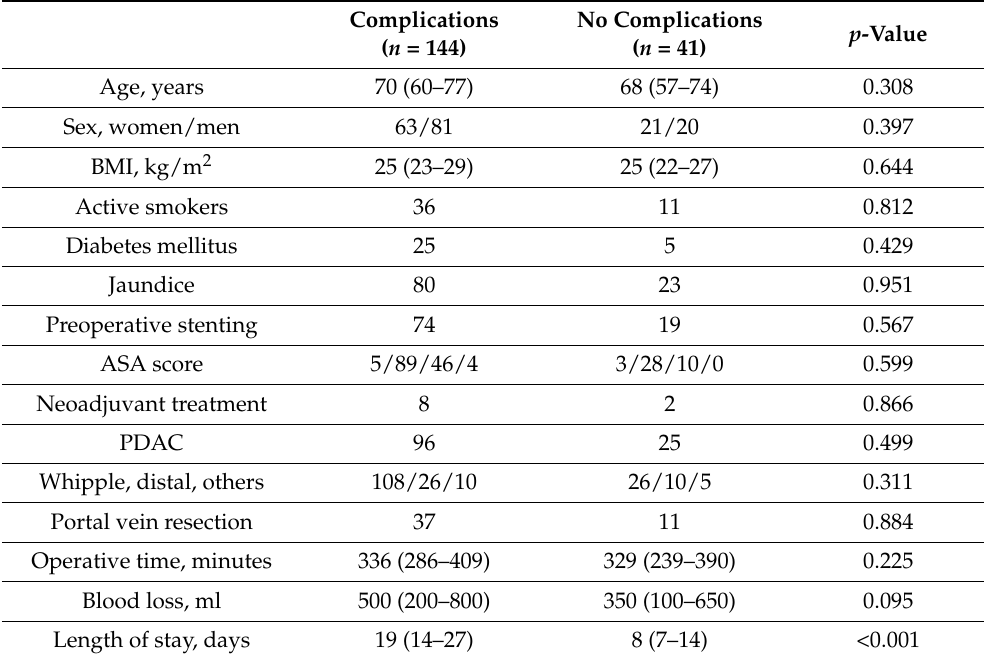
Table 1. Demographics, intraoperative details, and length of stay for patients with and without complications.